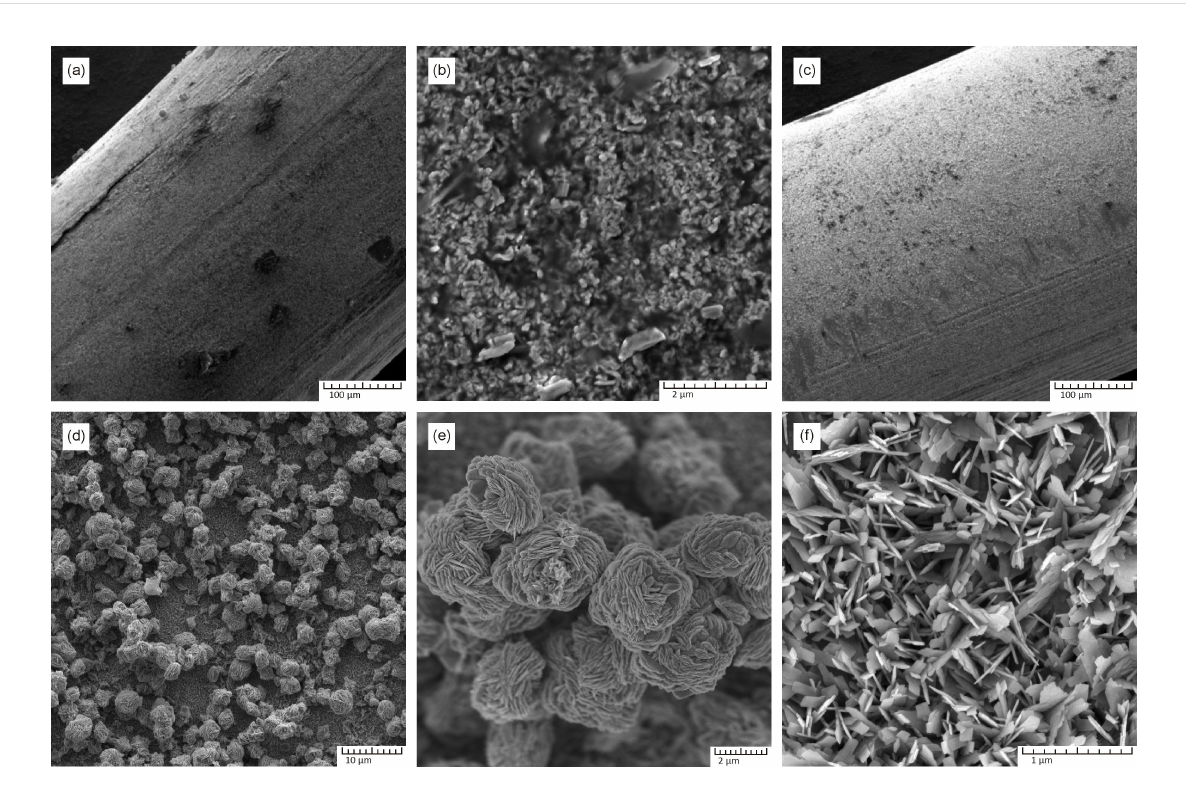
Figure 1: SEM images of copper oxide samples. (a, b) General view and morphology of a CuO film obtained by thermal oxidation on a copper wire; (c, d) general view of a copper wire with CuO layer obtained by chemical hydrothermal oxidation; (e) 3D flower-like nanostructured formations on the surface of the main CuO layer